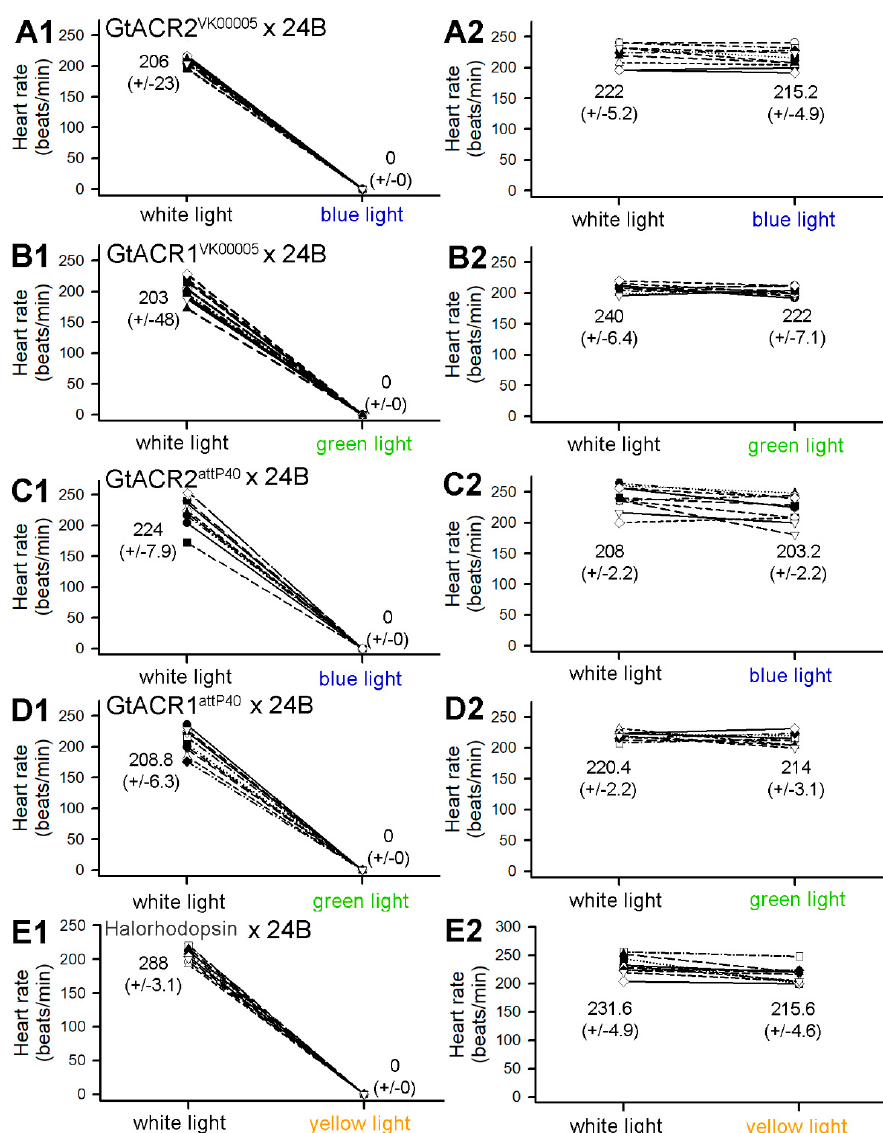
Figure 2. Heart rates of intact larvae from each line before and during exposure to the appropriate wavelength of light. Heart rates for all larvae in the GtACR2 VK00005 × 24B line ( A1 ), the GtACR1 VK00005 × 24B line ( B1 ), the GtACR2 ATTP40 × 24B line ( C1 ) , the GtACR1 ATTP40 × 24B line ( D1 ), and the Halorhodopsin (eNpHR) × 24B line ( E1 ) decreased to zero after direct exposure to the light. The parental lines ( A2 , B2 , C2 , D2 , E2 ) showed no difference to the light exposure. Green (166.5 W/m 2 ), blue (101.3 W/m 2 ) or yellow (623.7 W/m 2 ) light was used. Mean (+/-SEM) values are presented next to each distribution.